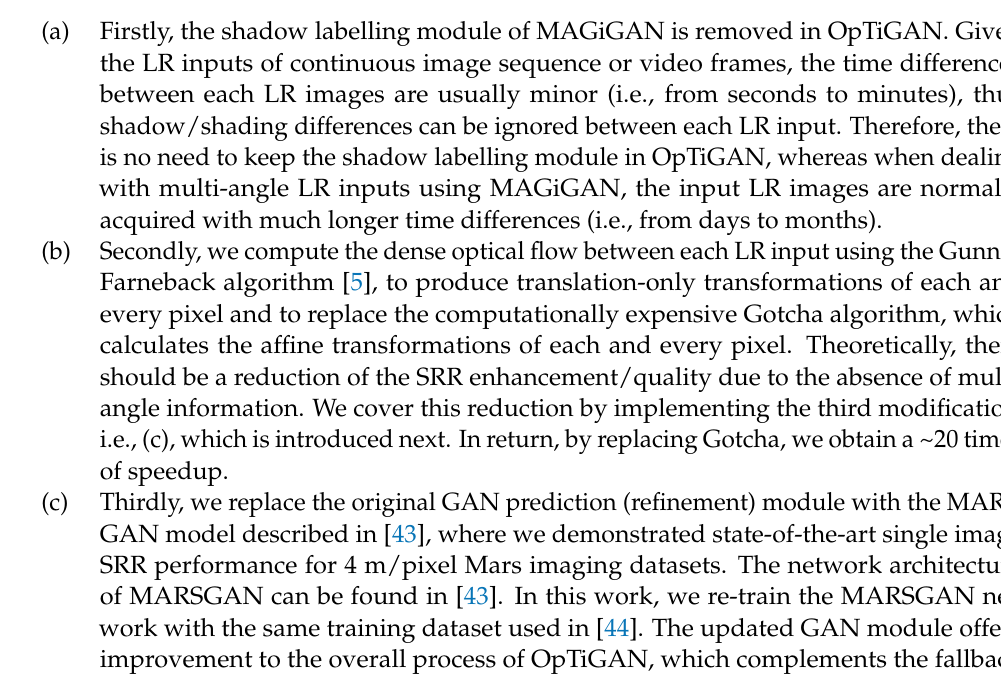
Figure 3. Flow diagram of the proposed OpTiGAN SRR system showing the same details as the flow diagram of MAGiGAN, in Figure 2, with changed components indicated in yellow. N.B.: darker coloured boxes represent the inputs and outputs.